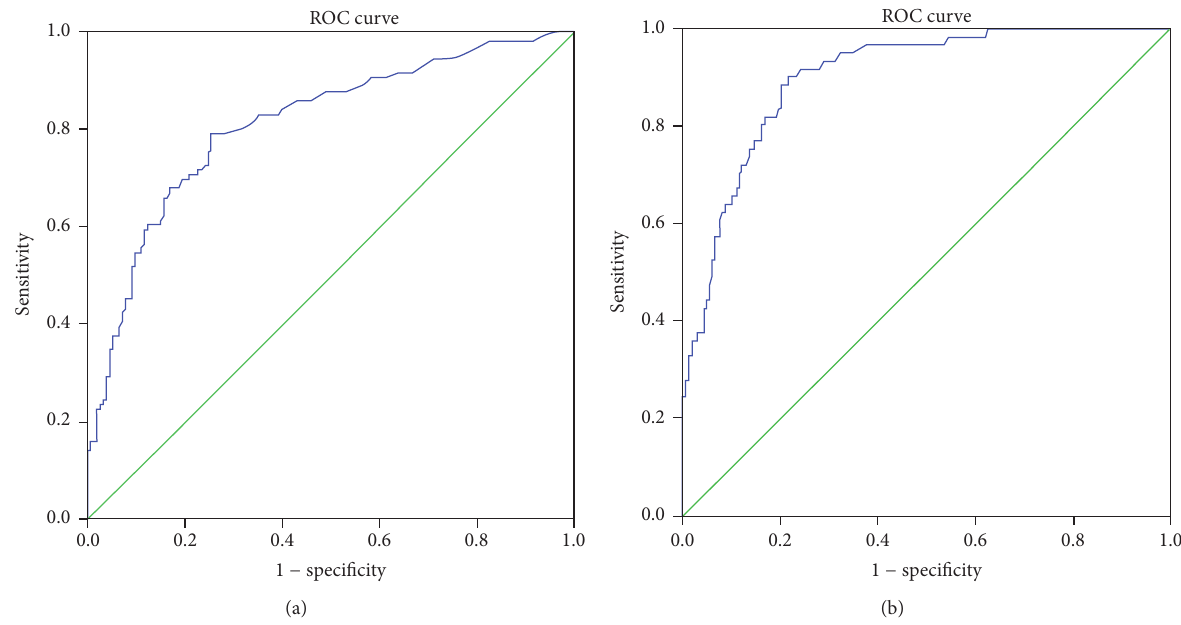
Figure 3: (a) Receiver Operating Characteristic (ROC) curve of NT-proBNP with heart failure defined as ejection fraction < 50%. Area under the curve is 0.811, 𝑝 < 0.001 . (b) Receiver Operating Characteristic (ROC) curve of NT-proBNP with heart failure defined as ejection fraction < 40%. Area under the curve is 0.902, 𝑝 < 0.001